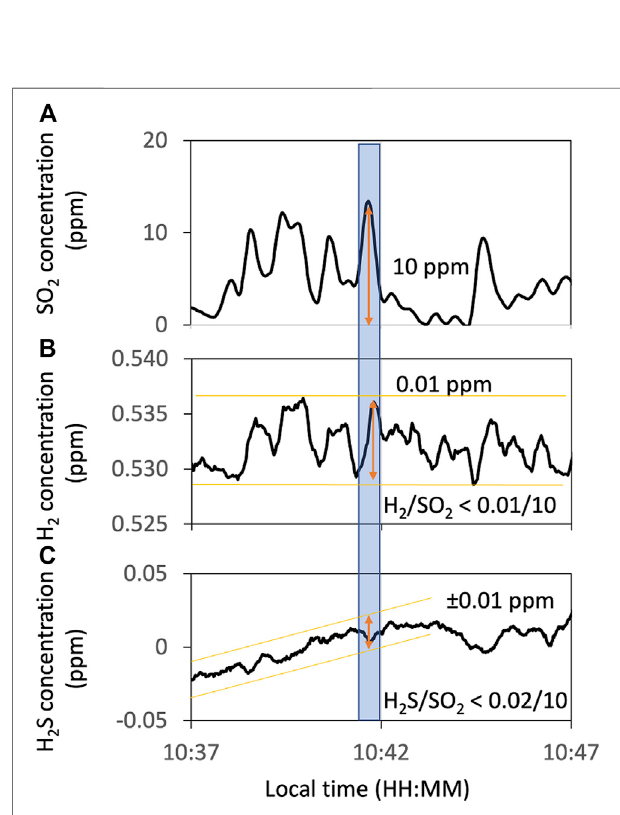
FIGURE4| ExampleoftheMulti-GASobservationofH 2 Sconcentration. Concentration timelines of SO 2 (A) as an indicator of the volcanic plume and H 2 (B) and H 2 S (C) measured using Multi-GAS on 13 January 2018. Orange lines and arrows show the range of variations of these timelines. The blue- fi lledareacorresponds totheperiodsusedtoestimatethemaximum H 2 / SO 2 and H 2 S/SO 2 ratios. All data are fi ltered by a 15-s running average to reduce instrumental noises.